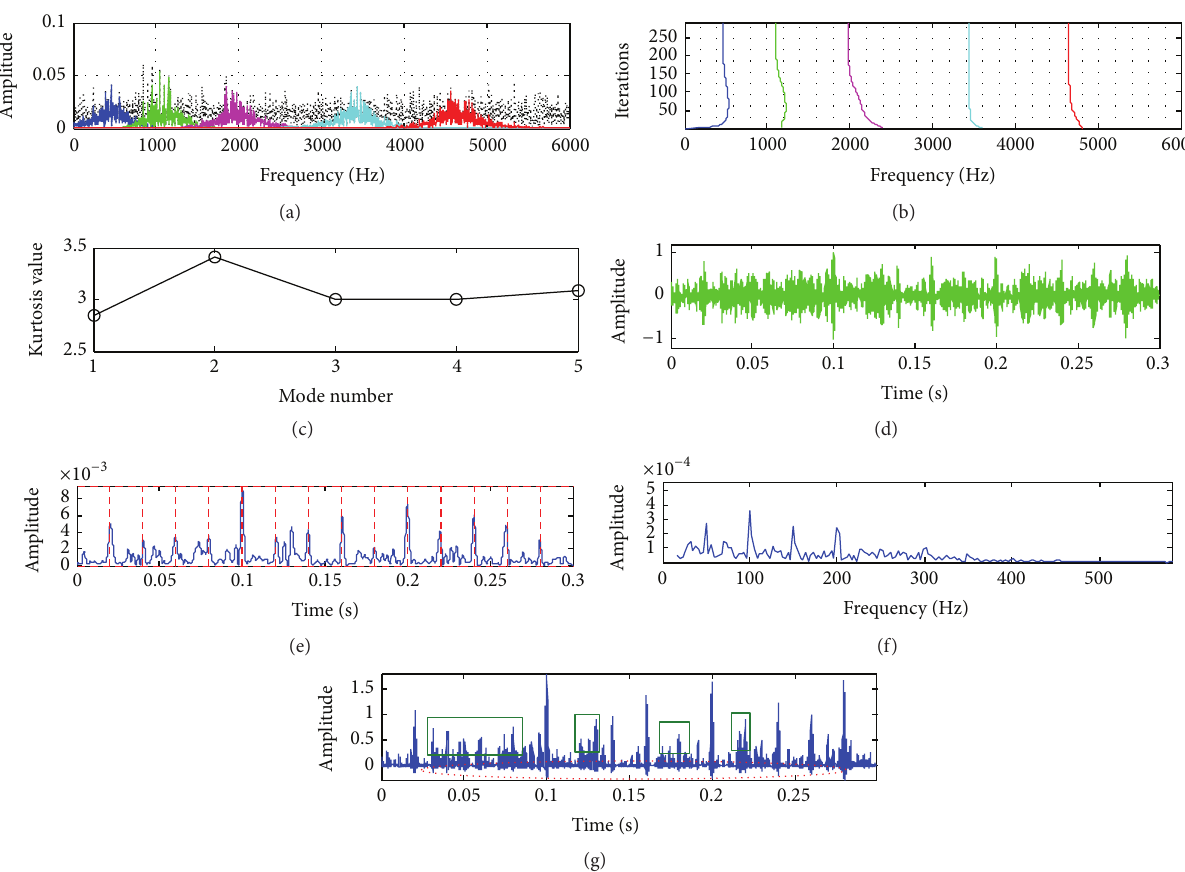
Figure 4: Analyzed results of the simulated signal shown in Figure 2(b) by the proposed method: (a) power spectrum obtained by VMD; (b) the number of iterations with central frequencies; (c) kurtosis curve of five decomposed modes; (d) waveform of the second mode; (e) enhanced waveform of the second mode by MTEO; (f) power spectrum of the enhanced waveform by MTEO; (g) enhanced waveform of the second mode by